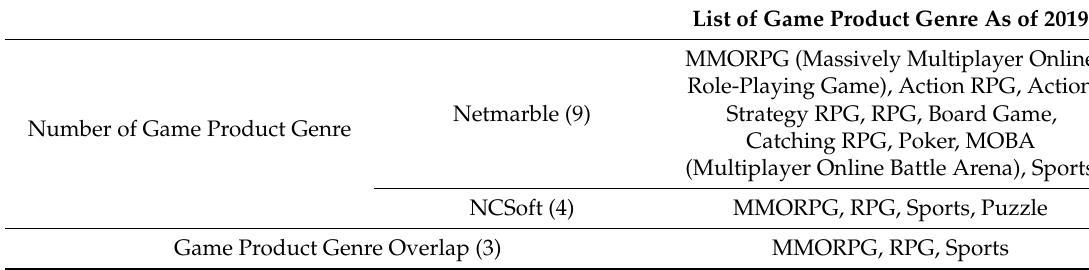
Table 3. Analysis of the Multimarket